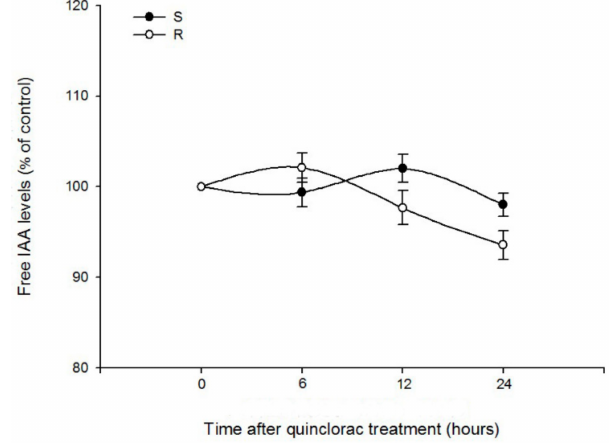
Figure 5. IAA contents in upper root tissues were measured in S (susceptible, JNNX-S) and R biotypes (resistant, SSXB-R) after treatment with quinclorac (50 µ M) at 0 h, 6 h, 12 h and 24 h. Data are the mean values of at least three biological replicates. The standard errors of the means are described by vertical bars.